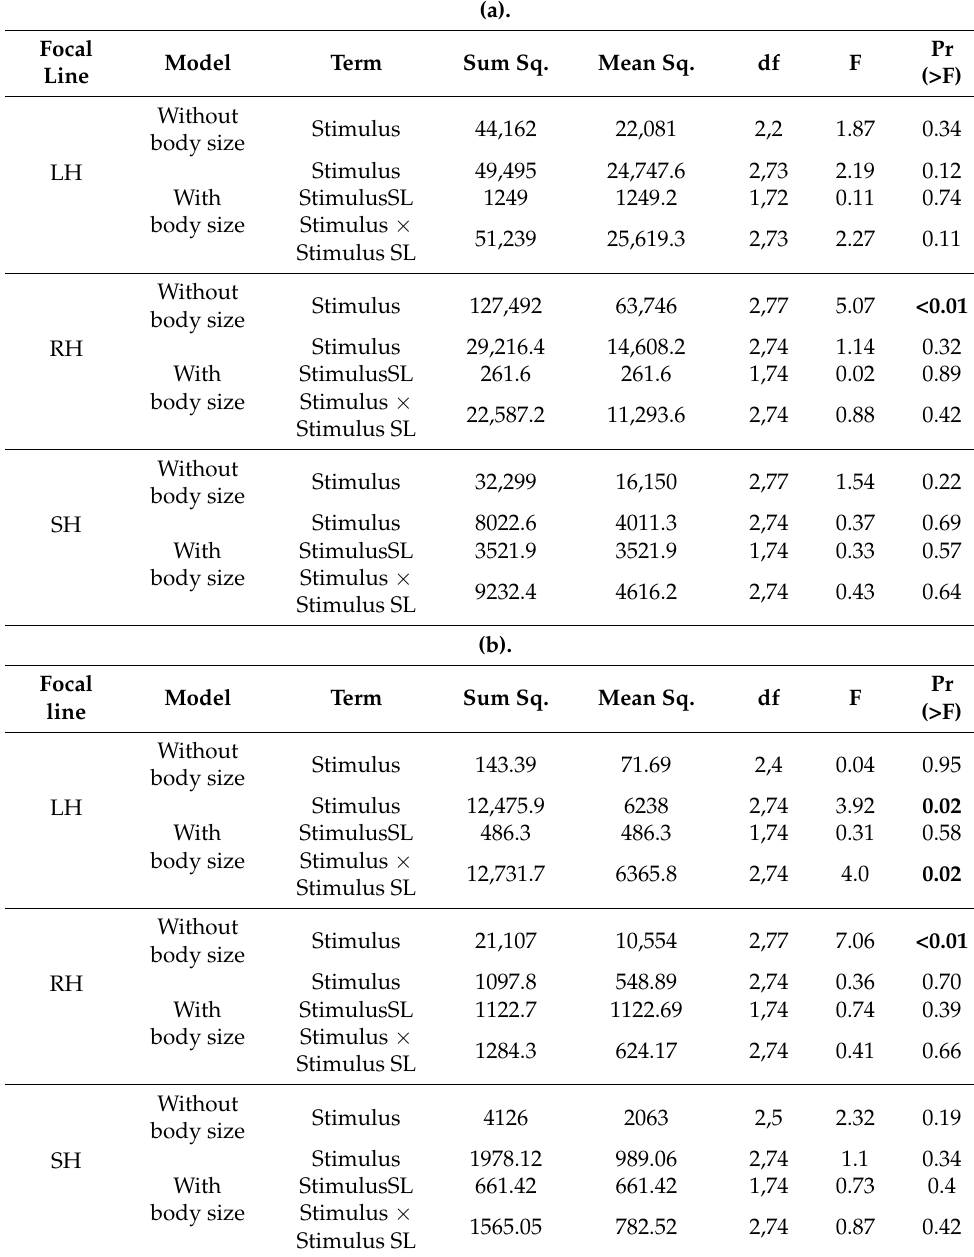
Table 1. Results of fixed effects from linear mixed effects models with and without inclusion of body size to test differences in time spent by focal (a) female and (b) male fish near the stimuli. Significant results are in bold. SL = Standard length; LH = Large-harvested; RH = Random-harvested; SH =